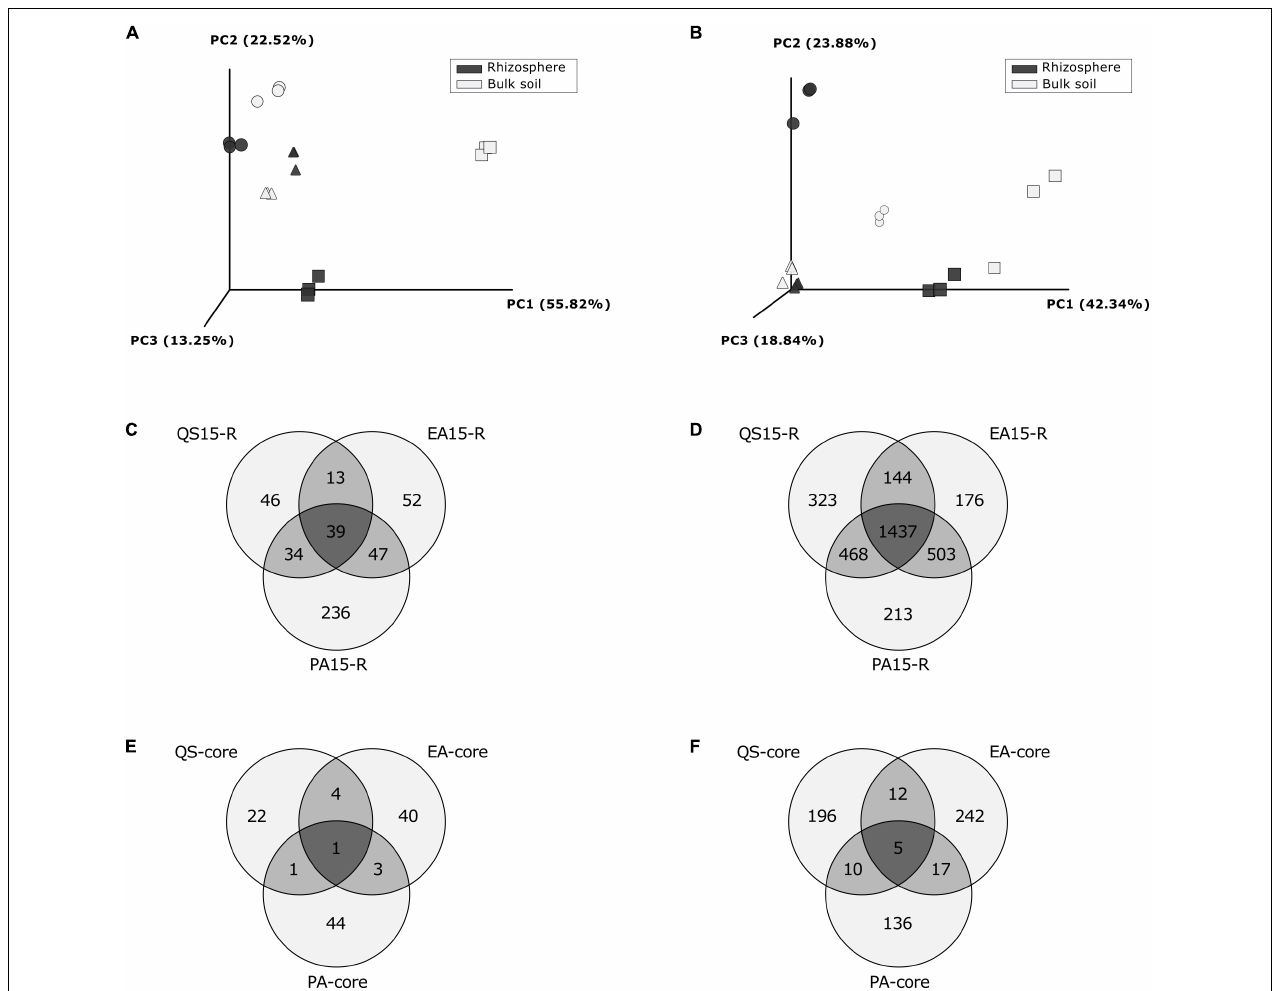
FIGURE 3 | Beta-diversity analysis and Venn diagrams: comparison between localities. Principal coordinates analysis (PCoA) based on weighted UniFrac Distances per locality and sample type, for fungi (A) and for prokaryotes (B) ; symbols represent localities: Circles: Quebrada Seca, Squares: El Algarrobo, Triangles: Pajonales; (C) Venn diagram for fungal OTUs registered in rhizosphere per locality; (D) Venn diagram for prokaryotic OTUs registered in rhizosphere per locality; (E) Venn diagram for rhizosphere specific fungal OTUs (fold change ≥ 3, between Rhizosphere and Bulk soil OTUs); (F) Venn diagram for rhizosphere specific prokaryotic OTUs (fold change > 3, between Rhizosphere and Bulk soil). QS, Quebrada Seca; EA, El Algarrobo; PA, Pajonales.